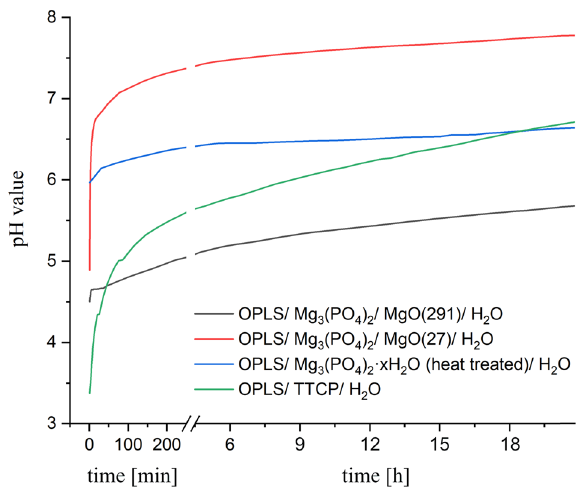
Fig. 6 pH values over time during the setting reaction of different bone adhesives